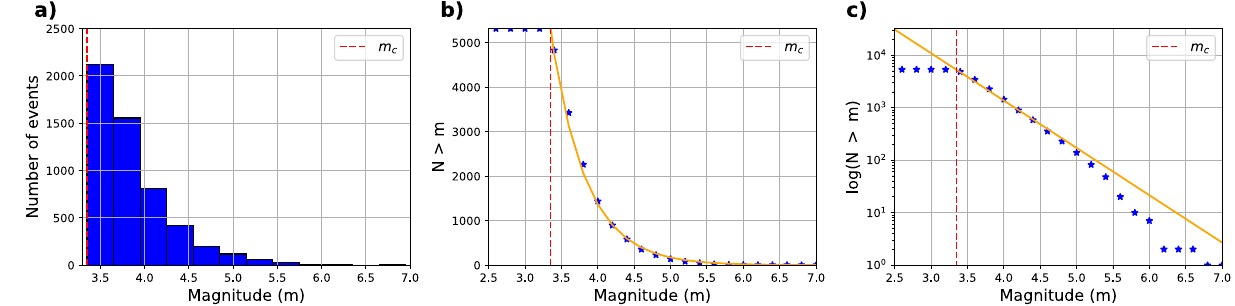
Figure 2. Solutions of completeness magnitude for the declusterized and filtered catalog. Figure ( a ) shows the frequency of the earthquakes as a function of magnitude. ( b ) The cumulative number of earthquakes (blue stars) and the Gutenberg–Richter equation that best fits the solution (orange); ( c ) shows the logarithmic version of ( b